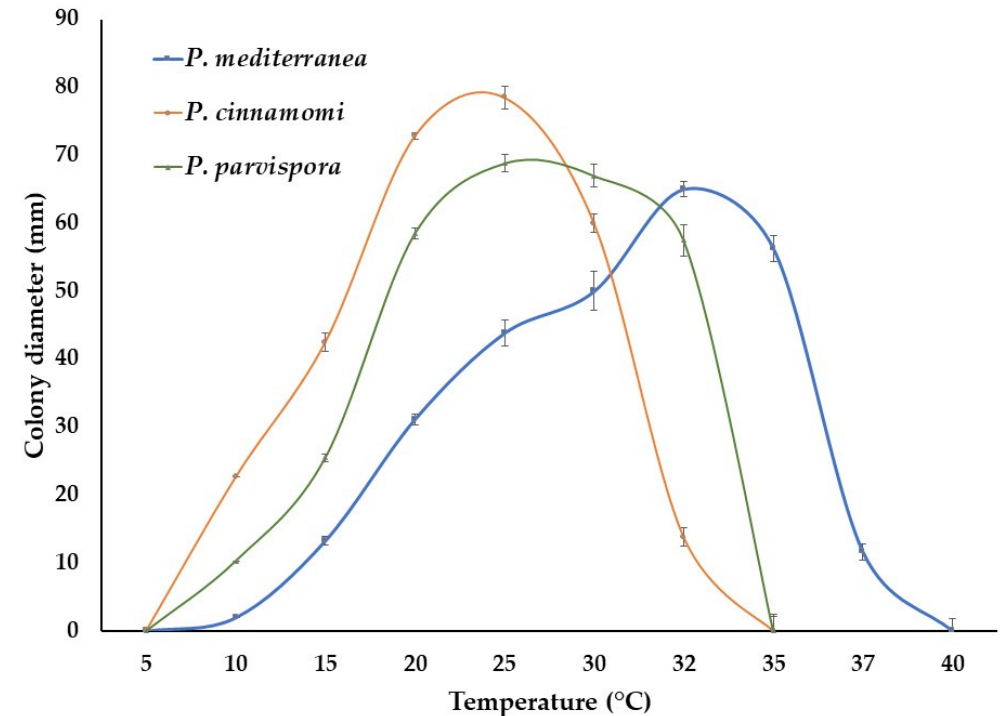
Figure 4. Mean colony diameter ( ± standard deviation) of P. cinnamomi (CB21), P. mediterranea (CB84) and P. parvispora (CB86) after 96 h on CA in the dark at different temperatures.